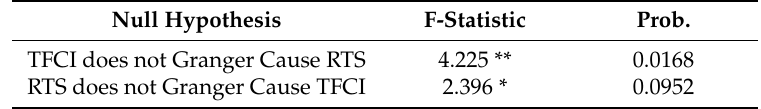
Table 4. Granger causality tests on TFCI and RTS for April 2005–June